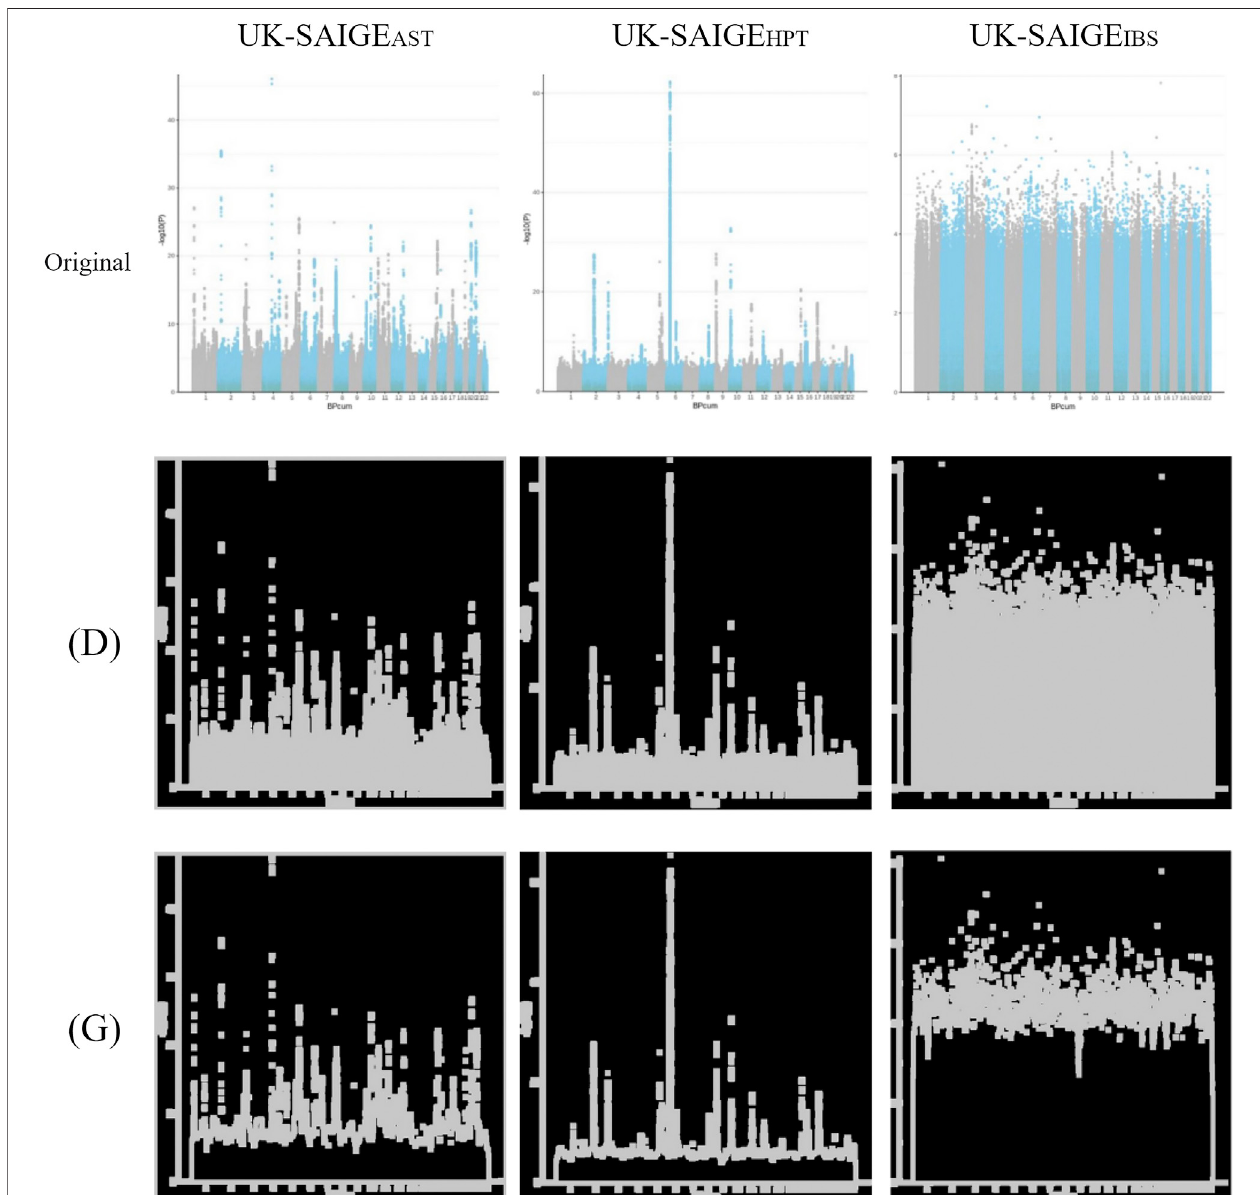
FIGURE 3 | Unprocessed Manhattan plots of UK-SAIGE AST , UK-SAIGE HPT , and UK-SAIGE IBS ( “ original ” labeled) were adjusted by image processing for dilation [(D) labeled] and morphological gradient calculation [(G) labeled].